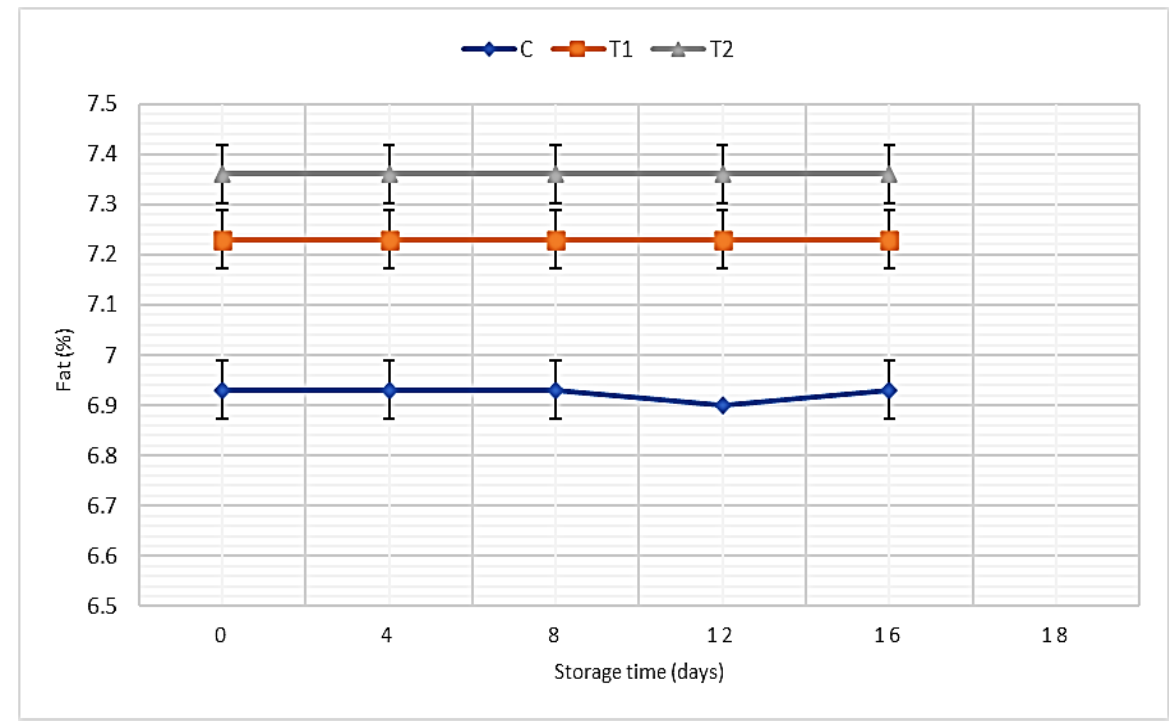
Figure 5. Fat percentages of SLY samples without and with REO addition during storage up to 16 days.